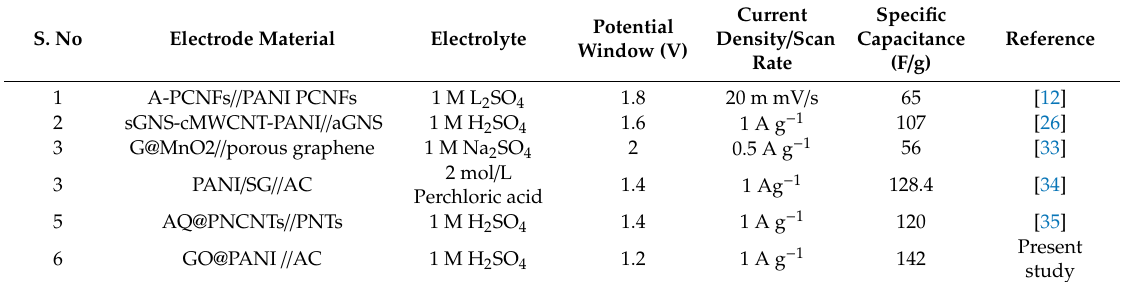
Table 1. A performance comparison of specific capacitance values in this work with previous asymmetric SCs. S. No